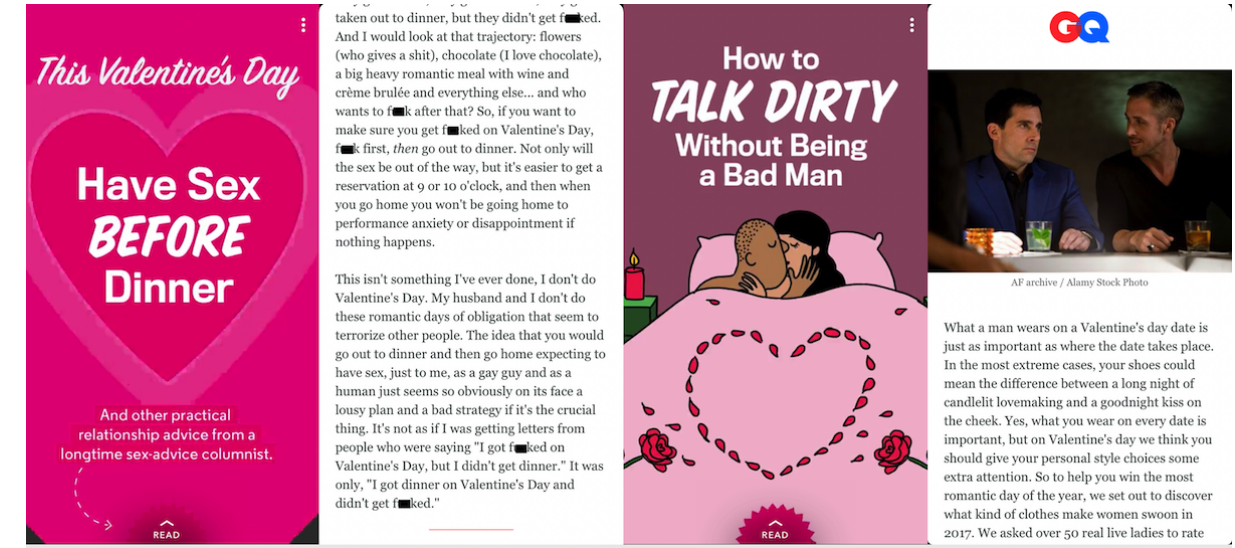
Figure 3. Examples of sexual health topics posted to male-focused Discover channels.